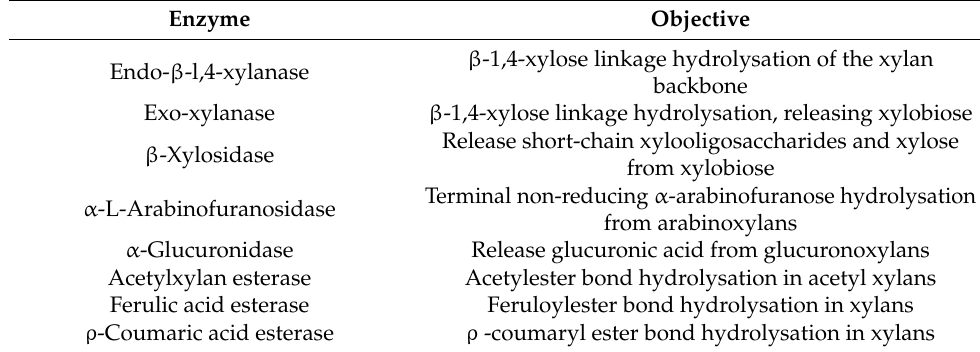
Table 3. Enzymes involved in the hydrolysis of complex heteroarabinoxylans. Enzyme Objective β -1,4-xylose linkage hydrolysation of the Endo- β -l,4-xylanase